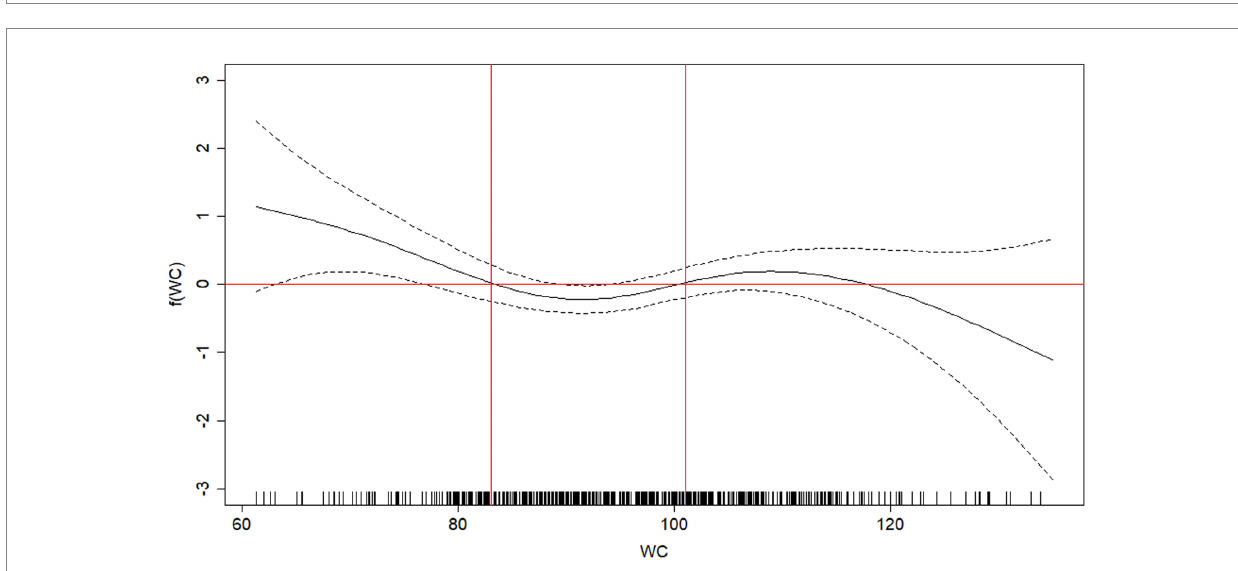
FIGURE 2 Attenuated function of mortality in older adults as a function of waist circumference (WC). Viçosa, MG, Brazil, 2009 -2018. The solid black line represents the regression line, and the dotted lines represent the 95% confidence interval. Cutoff points for WC: <83 cm; between 83 and 101 cm and ≥ 101